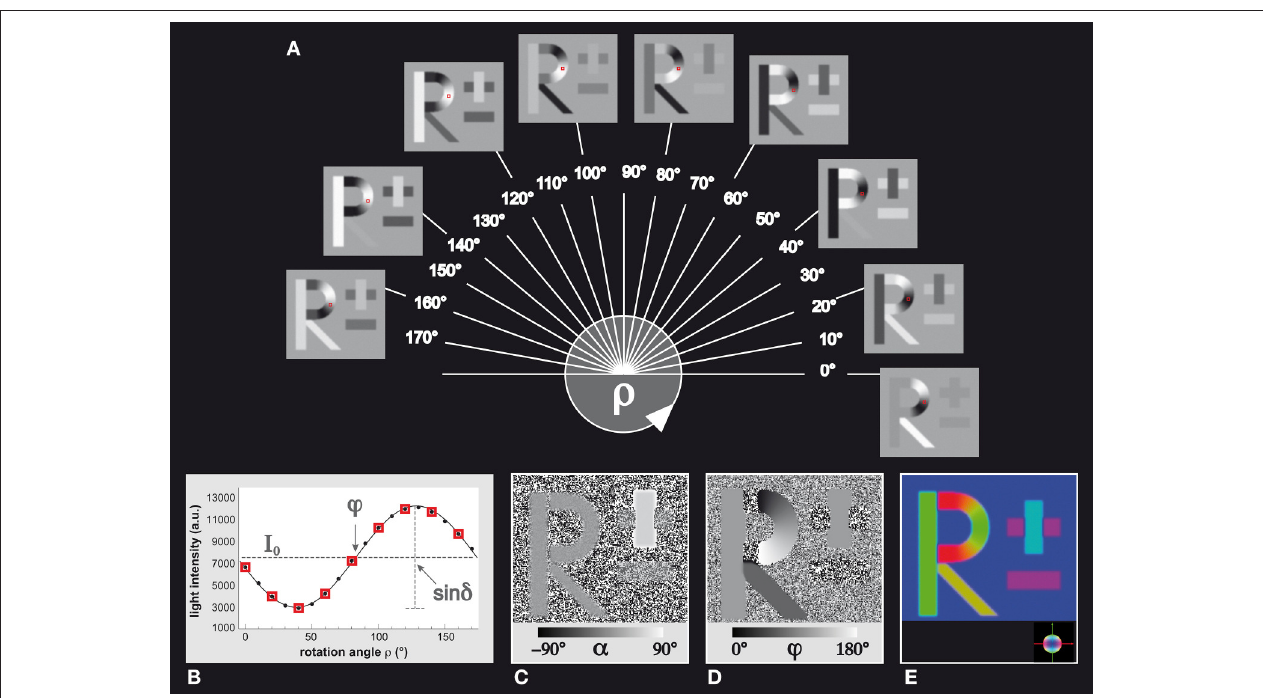
FIGURE 2 | Simulated 3D-PLI reference dataset. (A) The standard 3D-PLI measurement yields 18 images corresponding to equidistant rotation angles ρ between 0 ◦ and 170 ◦ . Here, a selection of nine generated images of simulated birefringent structures (the letter R and the ± sign) is shown. Each image has a size of 200 × 200 pixels. The varying pixel intensities are comparable to observed signals in measurements of brain sections. The red squares indicate a native voxel of interest that is displayed (B) in terms of the observed light intensity as a function of the rotation angle. The physical model that underlies 3D-PLI provides a sinusoidal description of the simulation (continuous black line), and relates (C) its amplitude to the inclination angle α via the retardation value sin δ and (D) its phase to the direction angle ϕ . The introduced effects of blurring and noise are evident: the minus sign in the direction map (D) , for example, shows direction angles that are spread around the initial direction ϕ = 0 ◦ by ± 2.5 ◦ . In a π -periodic system, this is equivalent to an angle range between 177.5 ◦ and 2.5 ◦ . (E) Visualization of the FOM with the determined vectors −→ u encoded in RGB color space (see color sphere for the relation between orientation and